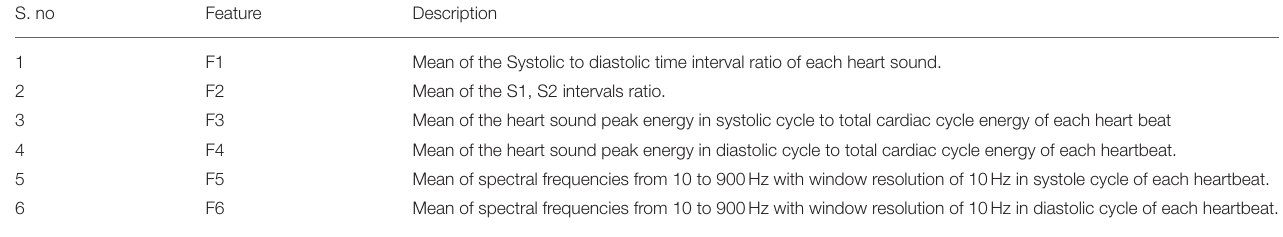
TABLE 1 | Cardiac sounds feature sets.